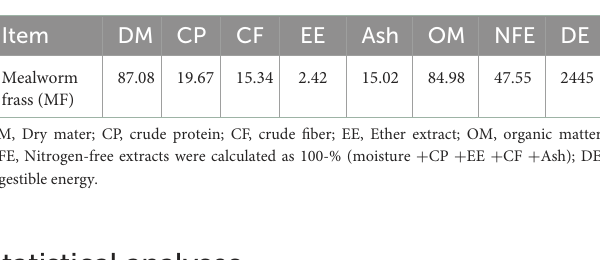
TABLE 2 The chemical composition of mealworm frass (on DM based).